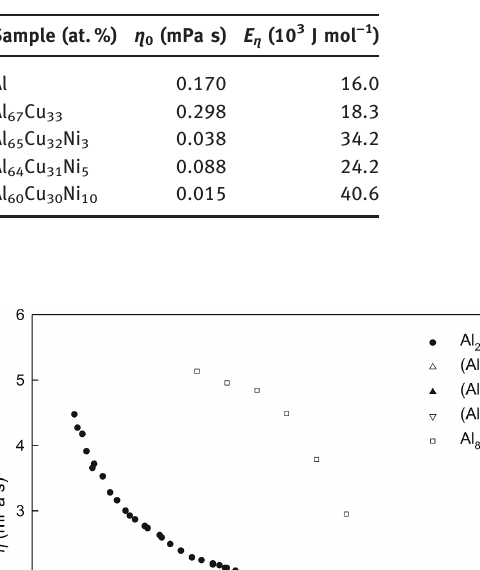
Table 1: Fitting numerical parameters of the Arrhenius-type eq. (2).